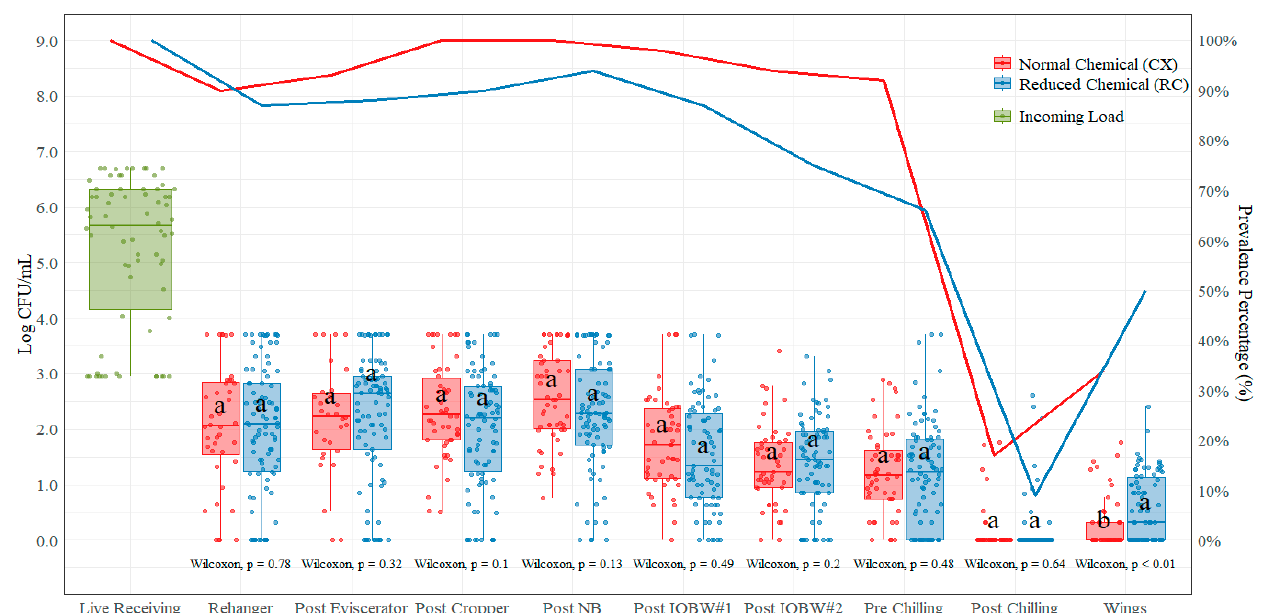
Figure 5. Campylobacter spp. counts (log CFU/mL) and prevalence (shown as solid lines) comparison on each of the ten locations during the evisceration process under normal process interventions (CX) and low-chemical process interventions (RC) on chicken rinses. In each boxplot, the horizontal line crossing the box represents the median, the top and bottom lines of the box represent the lower (0.25) and upper (0.75) quartiles, the vertical top lines represent 1.5 times the interquartile range, and the vertical bottom line represents 1.5 times the lower interquartile range. The dots represent the actual data points. a,b For each location, boxes with different letters are significantly different between treatments according to t -test analysis at p -value < 0.05.